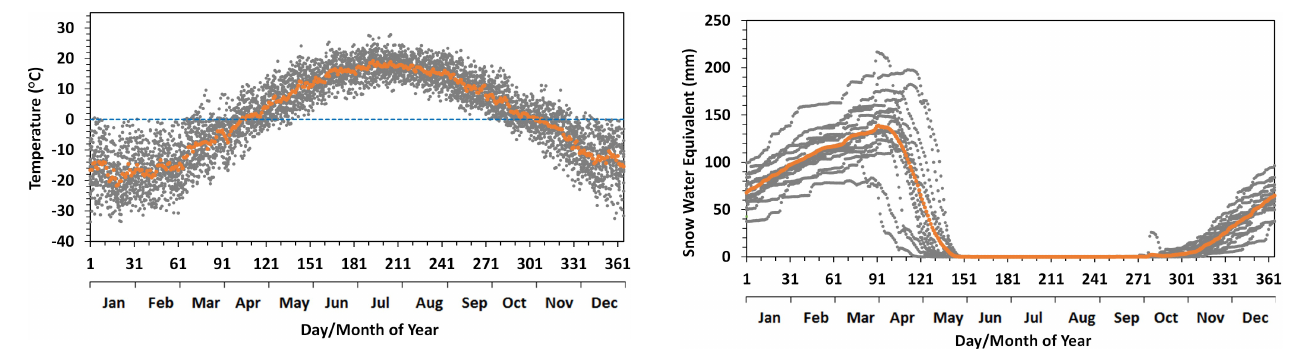
Figure 4. Daily snow water equivalent for the Albany River water- shed simulated by the EALCO model over the study period (2002– 2016). Orange dots represent the 15-year mean values.